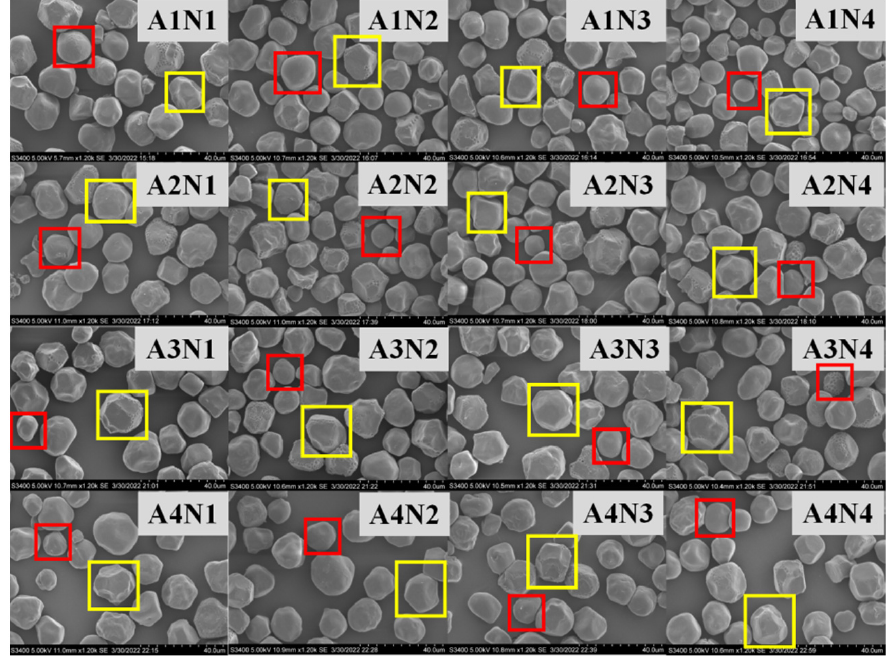
Figure 2. Effects of different nitrogen levels on the sorghum starch molecule morphology. (The starch molecule was observed at ×1200. Scale: 1 bar represents 40 μ m.)